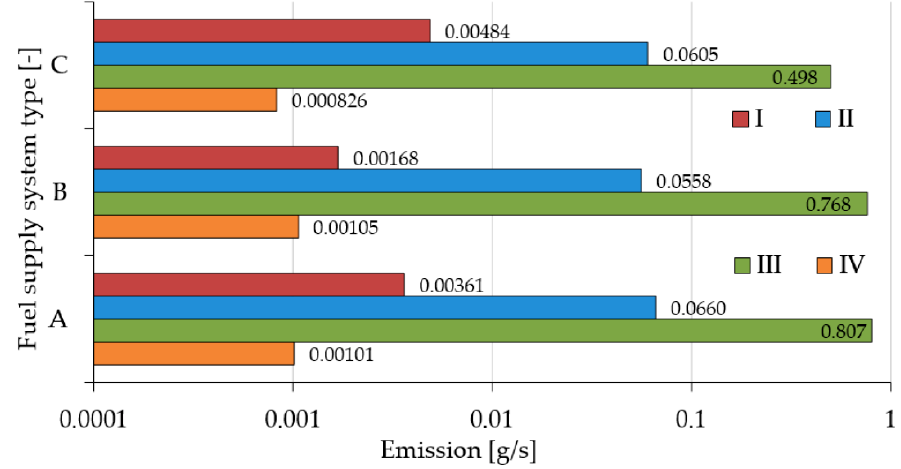
Figure 9. Comparison of emissions from the tested systems: A: Carburettor fuel supply system; B: Injector fuel supply system; C: Injector fuel supply system equipped with adaptive drive control system; Type of emission: I—HC, II—CO, III—CO 2 , IV—NO X .